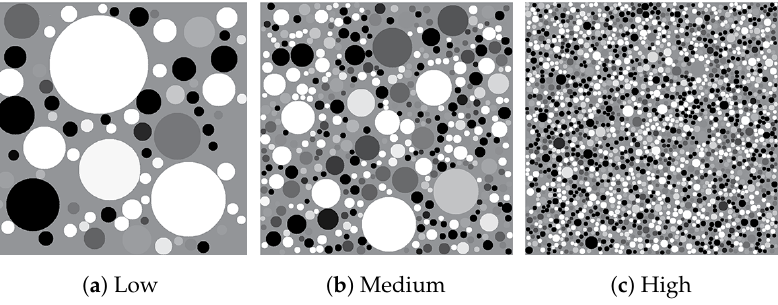
Figure 2. Levels for design factor “Complexity”.